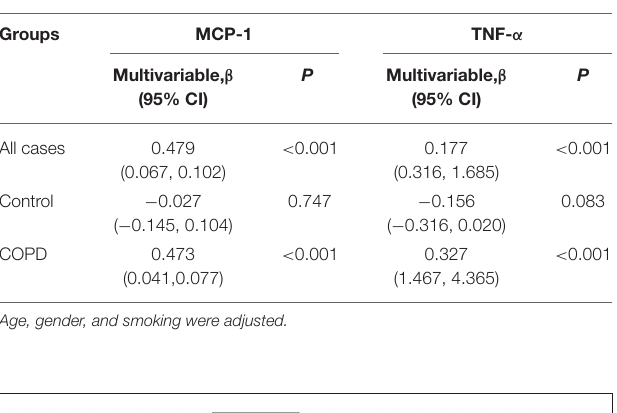
TABLE 3 | Associations of serum CYR61 with MCP-1 and TNF- α .